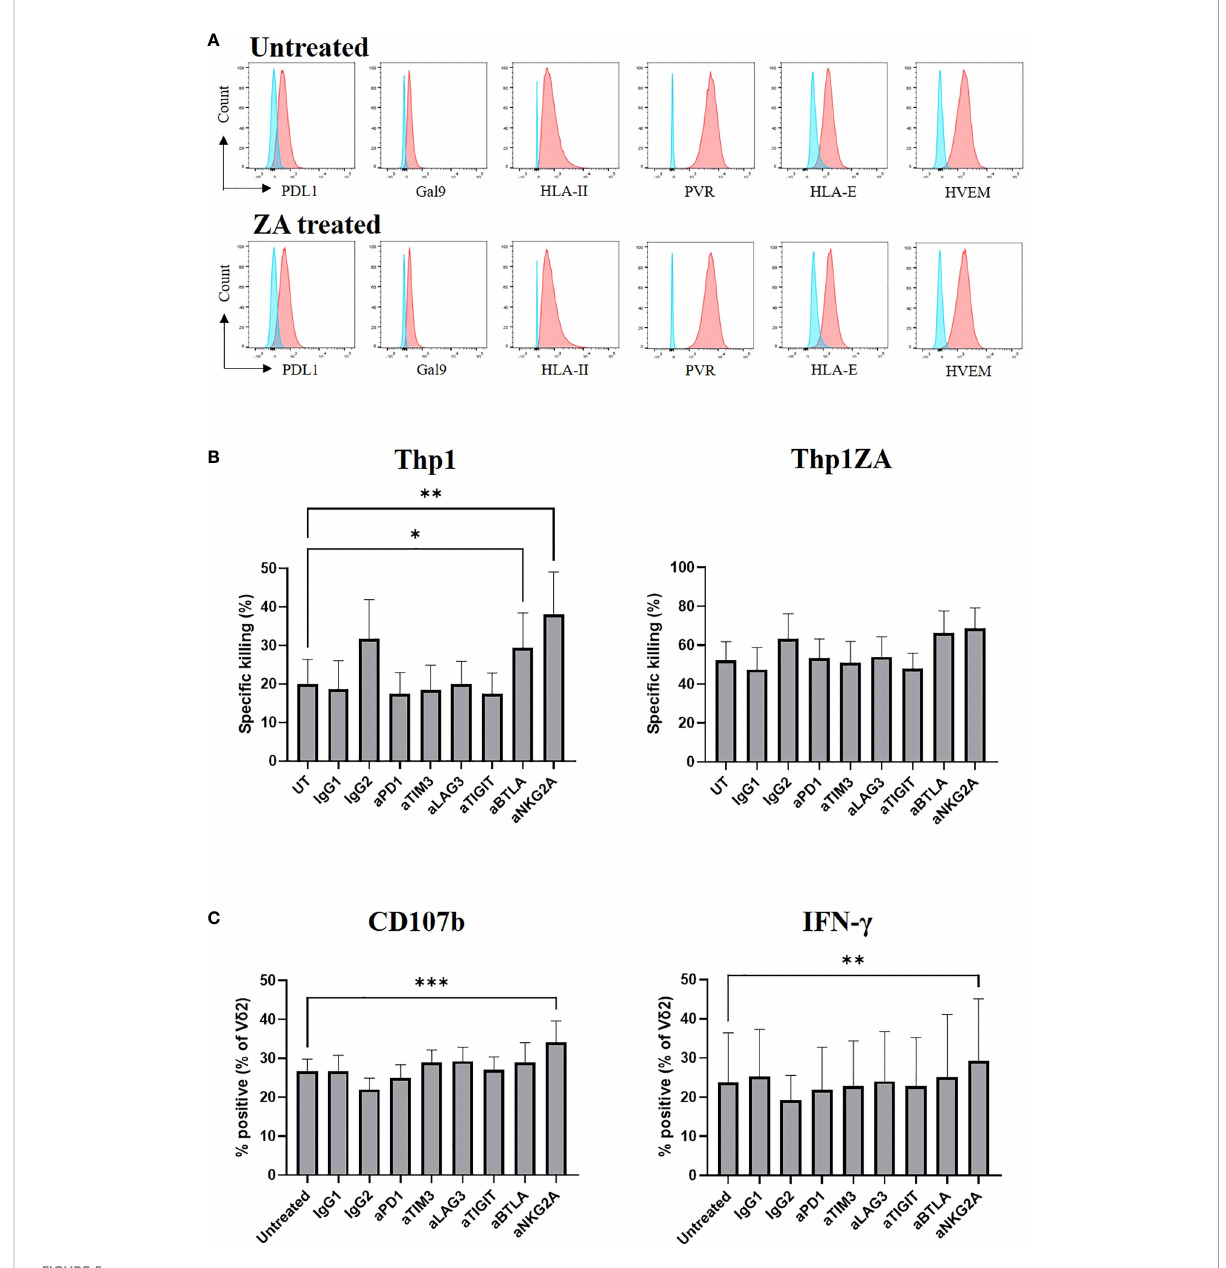
FIGURE 5 Expression of checkpoint receptor ligands (red) was compared to control (blue) on Thp1 cells with and without 50 m M ZA pre-treatment (A) . ZA expanded V d 2 cells were isolated and cultured with CTFR labelled Thp1 target cells, with or without 50 m M ZA pre-treatment, at a 1:1 ratio in the presence or absence of 5 m g anti-PD1, anti-TIM3, anti-LAG3,anti-TIGIT, anti-BTLA and anti-NKG2A. Speci fi c killing of tumour cells was calculated following 16 hours (B) and production of CD107b and IFN g by V d 2 cells was assessed by ICS and fl ow cytometry following 4 hours (C) . N=7. *<0.05, mixed effects analysis with Dunnett ’ s post hoc for multiple pairwise comparisons. **p<0.005,